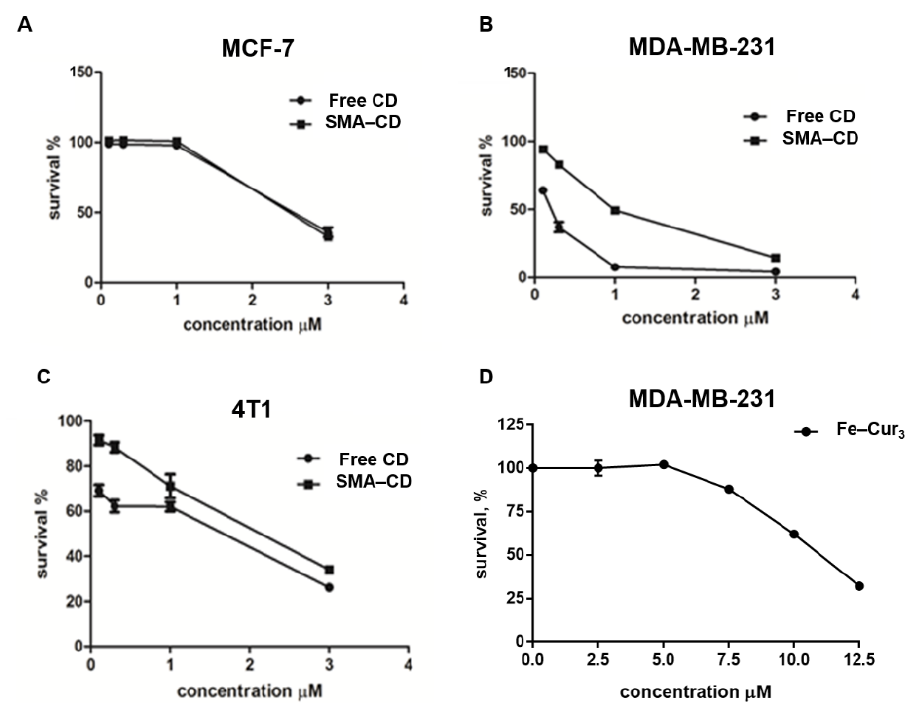
Figure 3. In vitro cytotoxic effect of CD, SMA–CD and Fe–Cur 3 , on hormone-responsive (MCF-7) and hormone resistant breast cancer cells (MDA-MB-231 and 4T1). ( A ) MCF-7, ( B ) MDA-MB-231, and ( C ) 4T1 cells were treated with different concentrations of CD and SMA–CD. ( D ) MDA-MB-231 cells were treated with Fe–Cur 3 . All cells were incubated for 48 h at 37 ◦ C, 5% CO 2 . Control wells were treated with vehicle only (0.2% dimethyl sulfoxide (DMSO)). At the end of treatment, the cell number was determined using the sulforhodamine B assay. Data are expressed as mean ± SEM ( n = 3). Nonlinear regression and IC 50 value determination was performed using GraphPad Prism 6. Differences were considered significant at p <